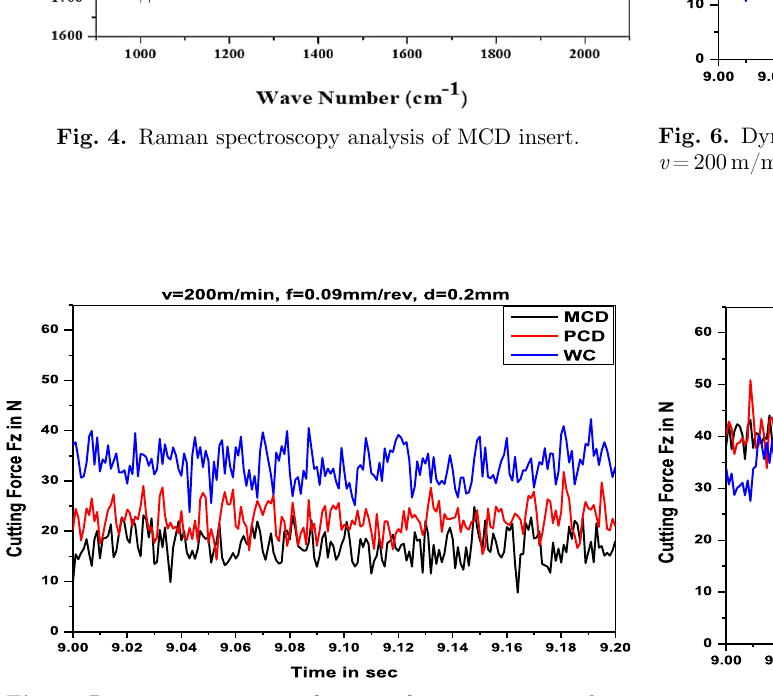
Fig. 7. Dynamic component of cutting force vs. time graph at v = 200m/min, f =0.18 mm/rev, d = 0.2mm.